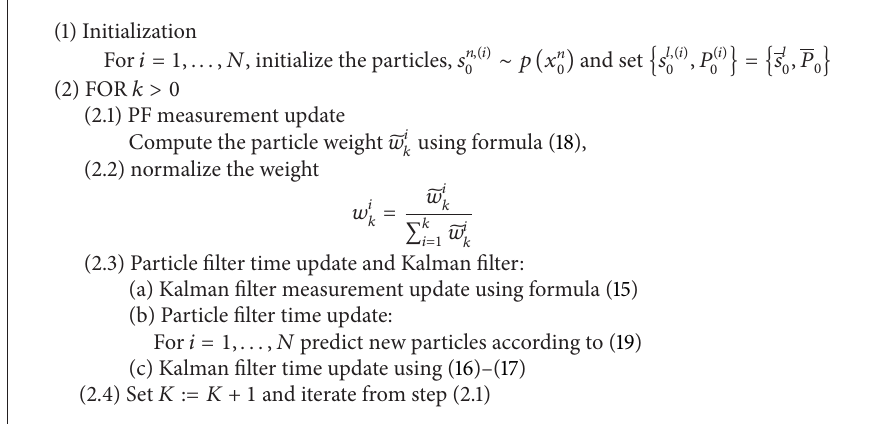
Pseudocode 2: Description of the Rao-Blackwellized particle